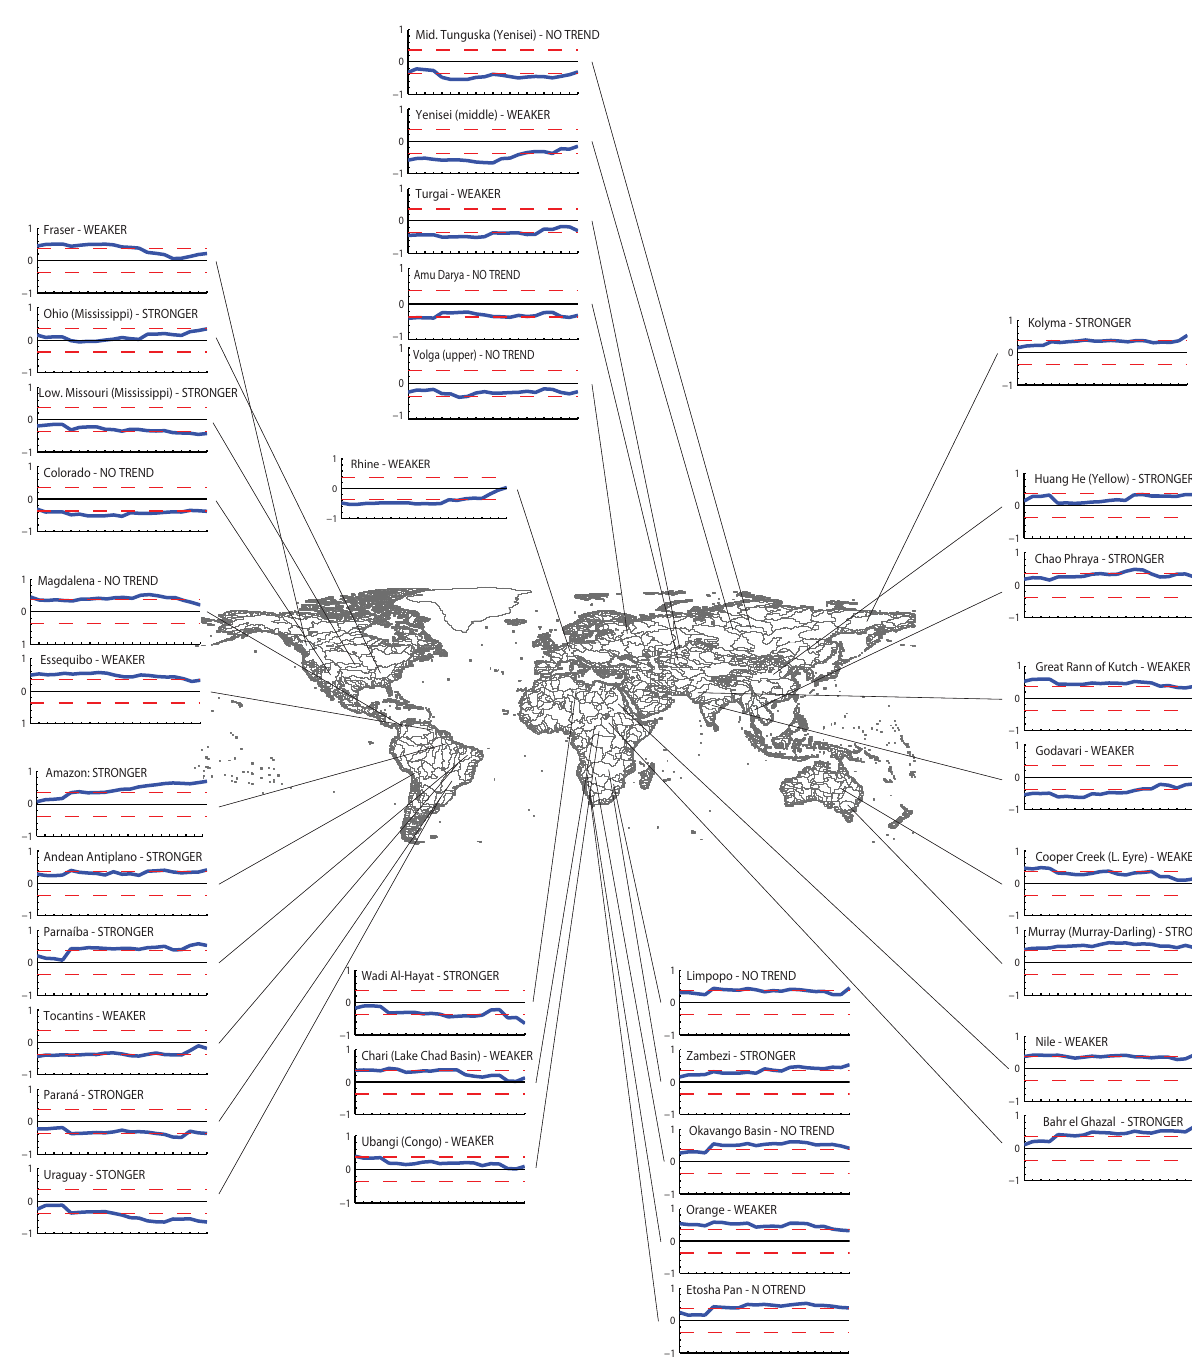
Fig. 7. Correlation (Pearson’s r ) between ln Q max and SOI DJF for 21yr moving windows centred on the years 1969–1989. On the line graphs, the axes are unlabelled due to space constraints: the x axes show years (1969–1999) and the y axes show the strength of Pearson’s r (+1 to − 1). The blue line indicates the strength of the correlation, and the red dashed lines indicate the critical values of the significance test (critical r =0.369/ − 0.369, α =0.10). The names of the basins are shown in text, as well as the trends in the strength of the correlation over time (no trend; stronger (i.e. strengthening over time); or weaker (i.e. waekening over time)). The significance of the trends was assessed using the Mann–Kendall text ( α =0.10). The results are shown for 35 basins, selected as per the description in Sect.